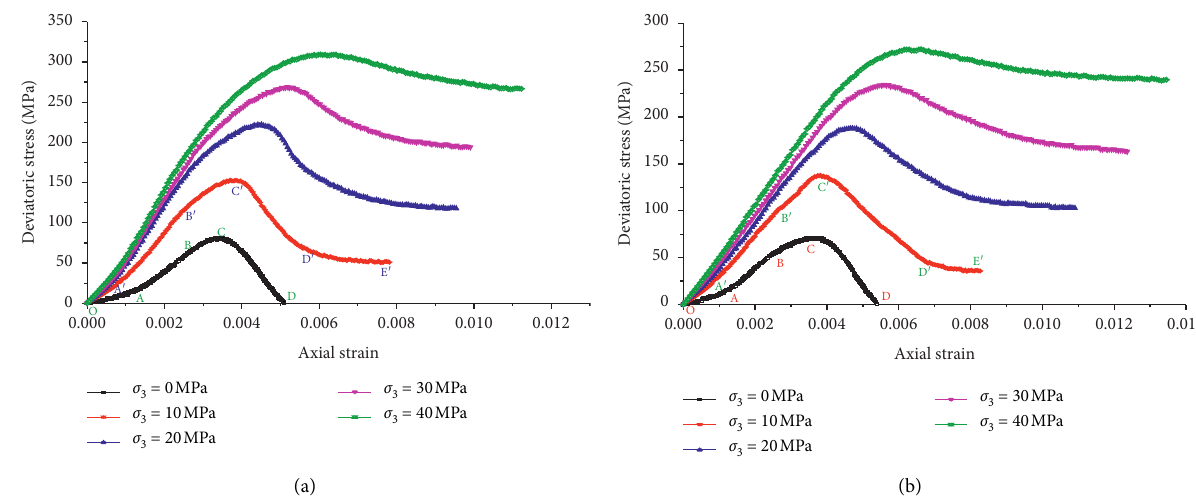
Figure 5: Compressive stress-strain curves under different confining pressure. (a) Natural state. (b) Saturated state.